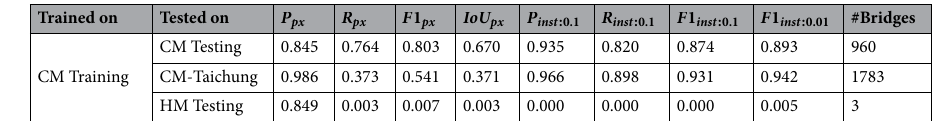
Table 1. Quantitative evaluation of the U-Net model trained on the 2017 contemporary map with full supervision. CM Training and CM Testing are the train/test split of the northern Taiwan tiles from 2017 contemporary map. CM Taichung is a separate test set from middle Taiwan of the 2017 contemporary map. * CM stands for contemporary map; HM stands for historical map. #Bridges shows the number of recognized